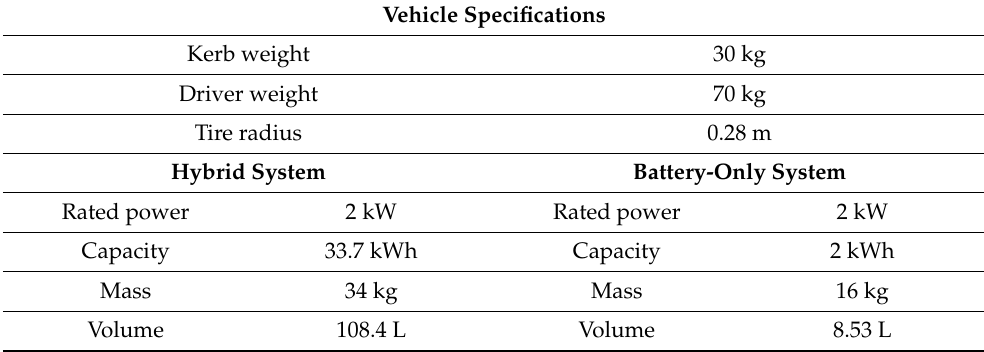
Table 2. Vehicle and energy system